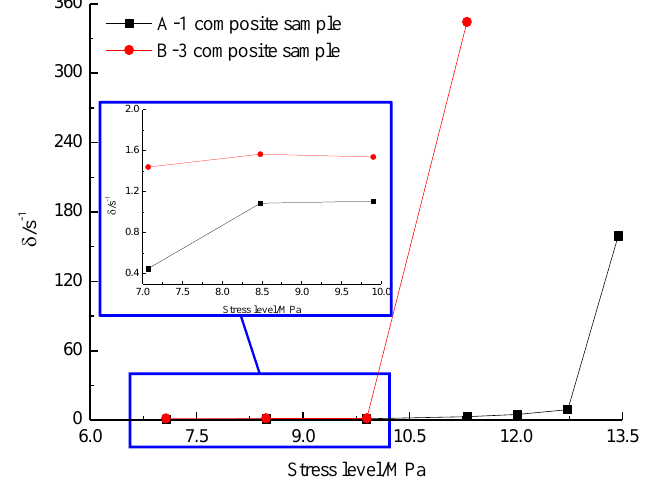
Figure 15. Comparison of δ values for A-1 and B-3 composite